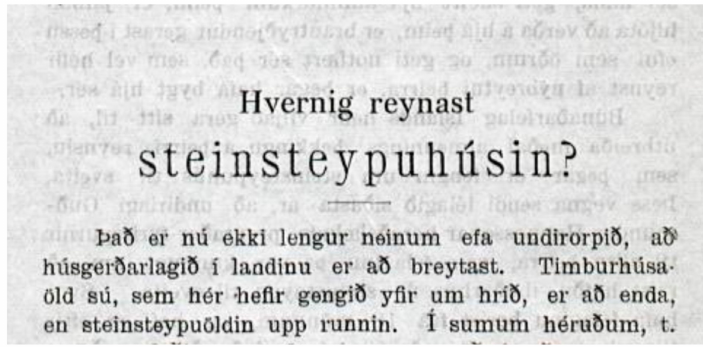
Figure 1. J ó n Þorl á ksson, Hvernig reynast steinsteypuh ú sin? B ú naðarrit , Vol. 25, 1911. Full article publicly available at t í